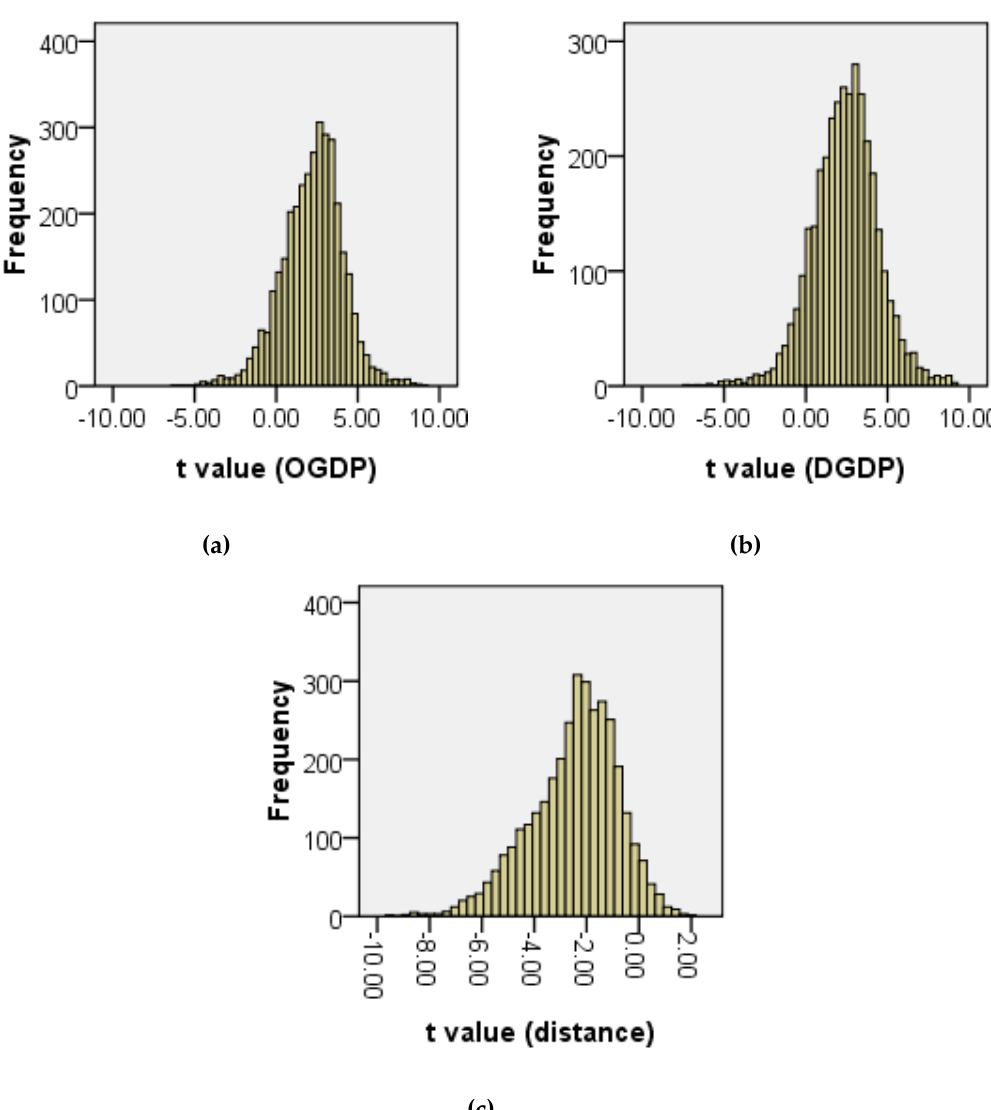
Figure 7. Histograms of t-statistics for three parameter estimations with the geographically weighted ordinary least square (GWOLS) model. ( a ) GDP at origin site (OGDP); ( b ) GDP at destination site (DGDP); ( c ) distance.